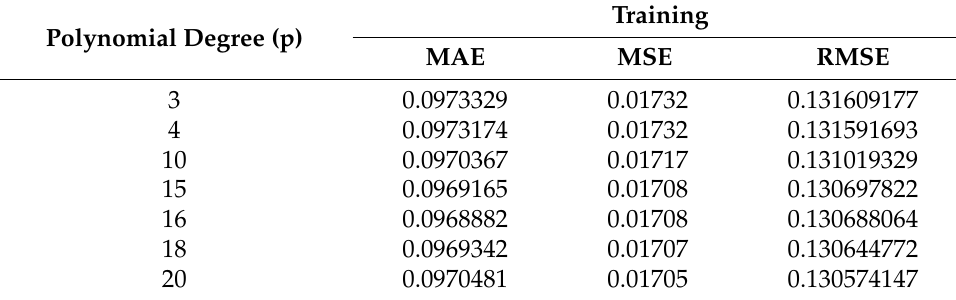
Table 10. PR: training performance metrics.